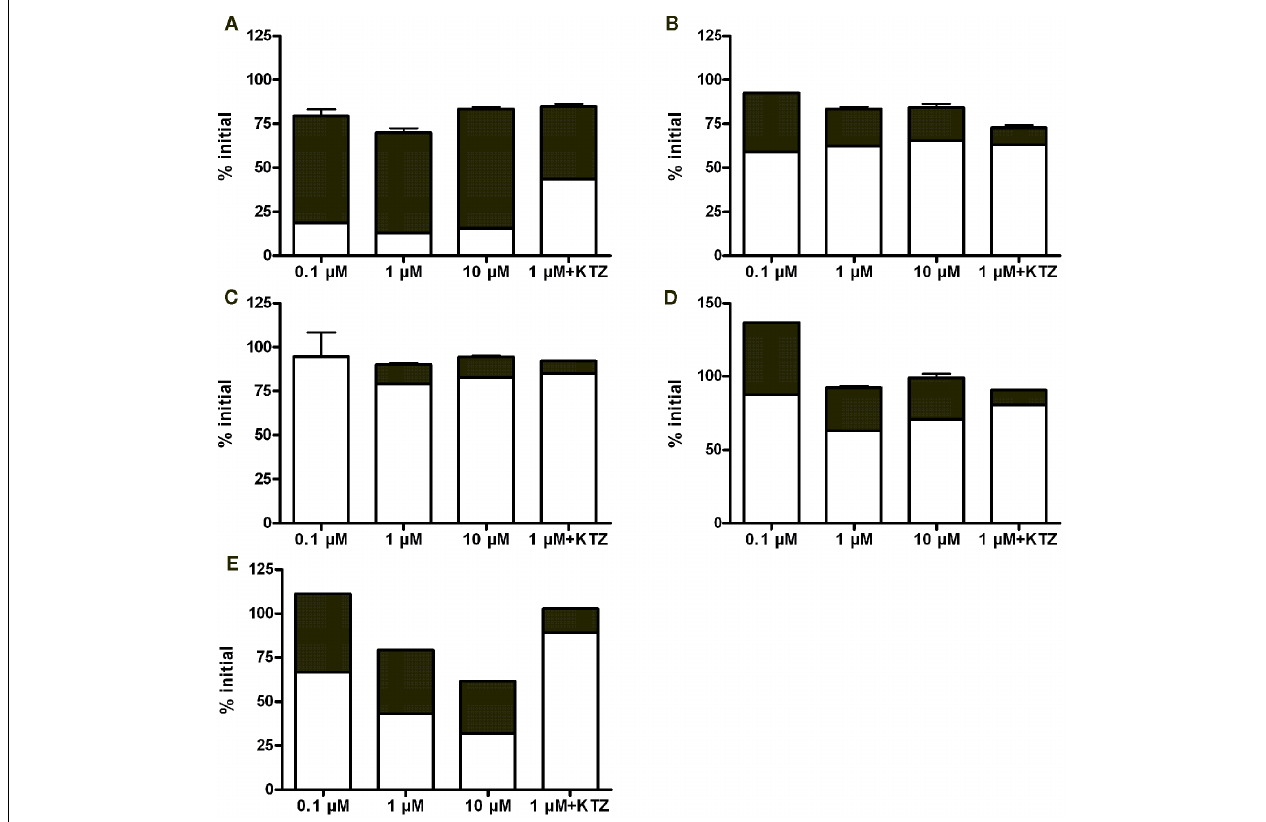
FIGURE 2 | Fractional concentrations of oxycodone (white bars) and noroxycodone (black bars) at the last time point (4h) in hepatocyte incubations from 3day (A), 2month (B), 5month (C), 4year (D), and adult (E) donors. Bars represent mean ± SD (single experiment in duplicate). KTZ, ketoconazole.